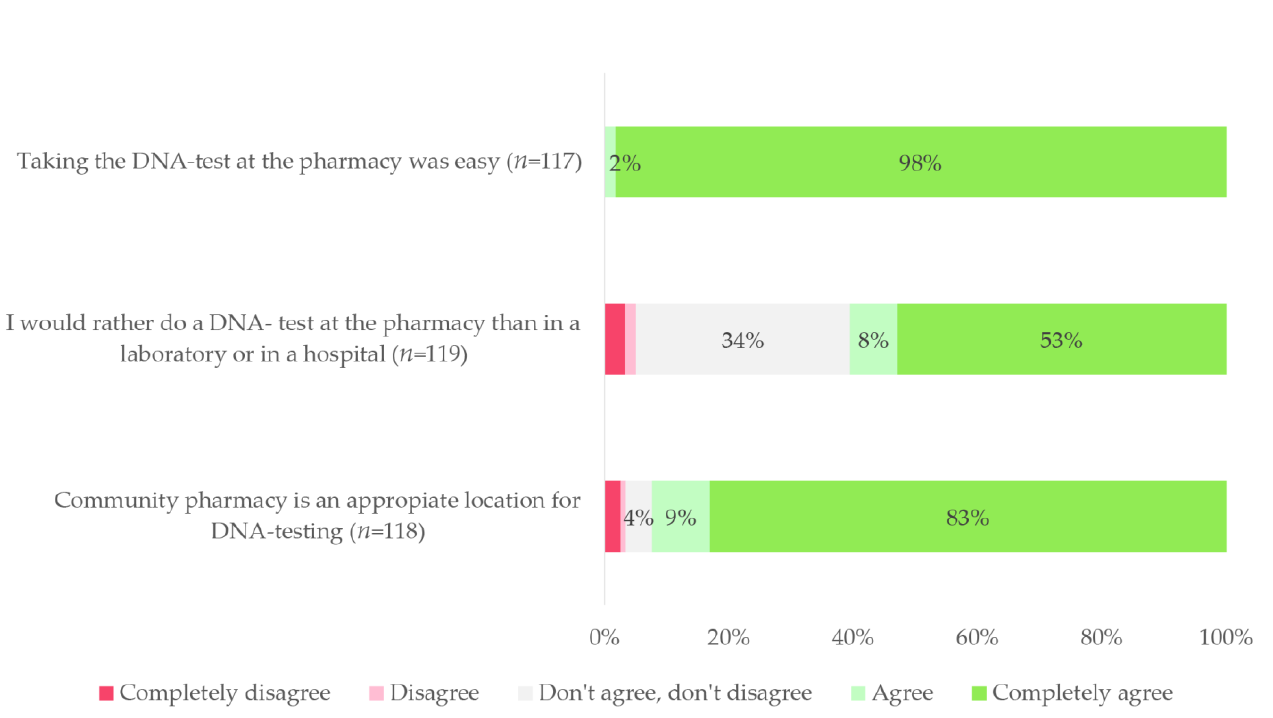
Figure 2. Patient survey results on pharmacogenetic testing in community pharmacy. DNA test: pharmacogenetic test. Percentages may not add to 100% because of rounding.